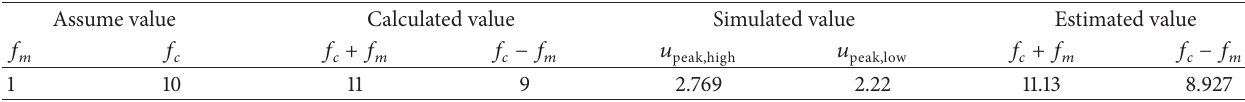
Table 2: Frequency estimation in DSB-SC